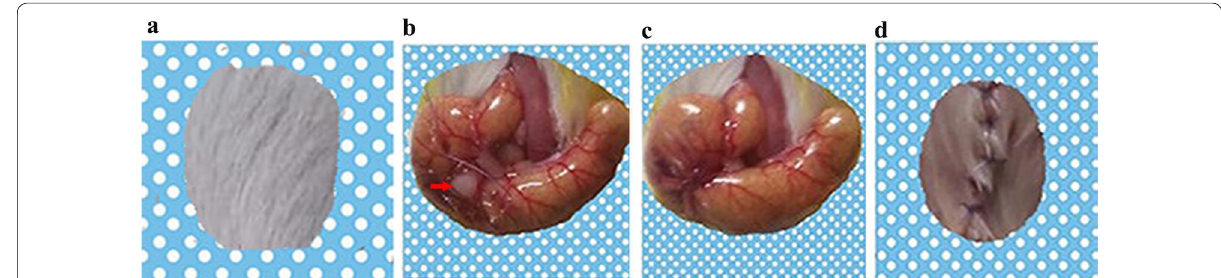
Fig. 1 The modeling process. Tumor fragments (approximately 1–2 mm 3 ) were transplanted onto the ceca colon. The picture represents the mouse orthotopic colon cancer modeling process, with specific steps from a d . A piece of tumor (each measuring 1–2 mm 3 ) is indicated with arrow →